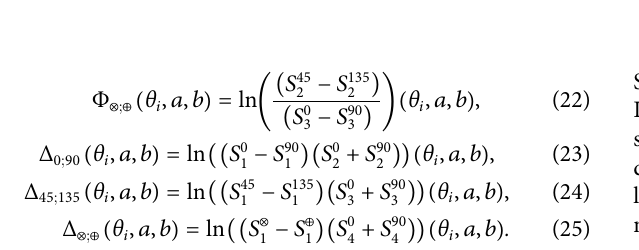
FIGURE4| Embossedtopographicmapsoflinear (A) Δ L ( θ 1 (cid:1) 0 . 4 rad 5 z 1 ≈ 25 μ m ) and (B) Δ L ( θ 2 (cid:1) 0 . 75 rad 5 z 2 ≈ 50 μ m ) andcircular (C) Δ C ( θ 1 (cid:1) 0 . 4 rad 5 z 1 ≈ 25 μ m ) and (D) Δ C ( θ 2 (cid:1) 0 . 75 rad 5 z 2 ≈ 50 μ m ) dichroism of myocardial histological